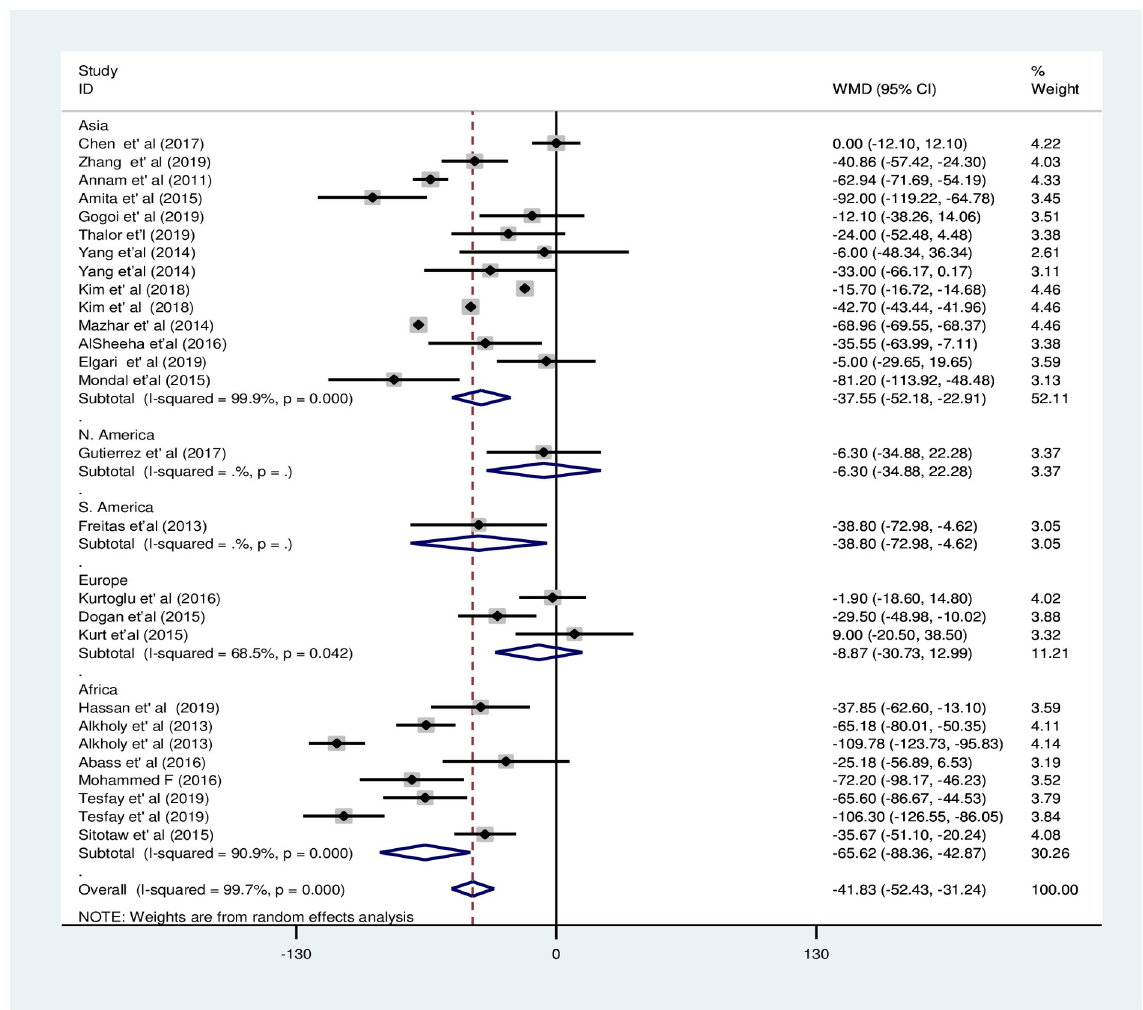
Fig 7. Forest plot of subgroup analysis for the pooled WMD estimate of PC by continent using random effect model.